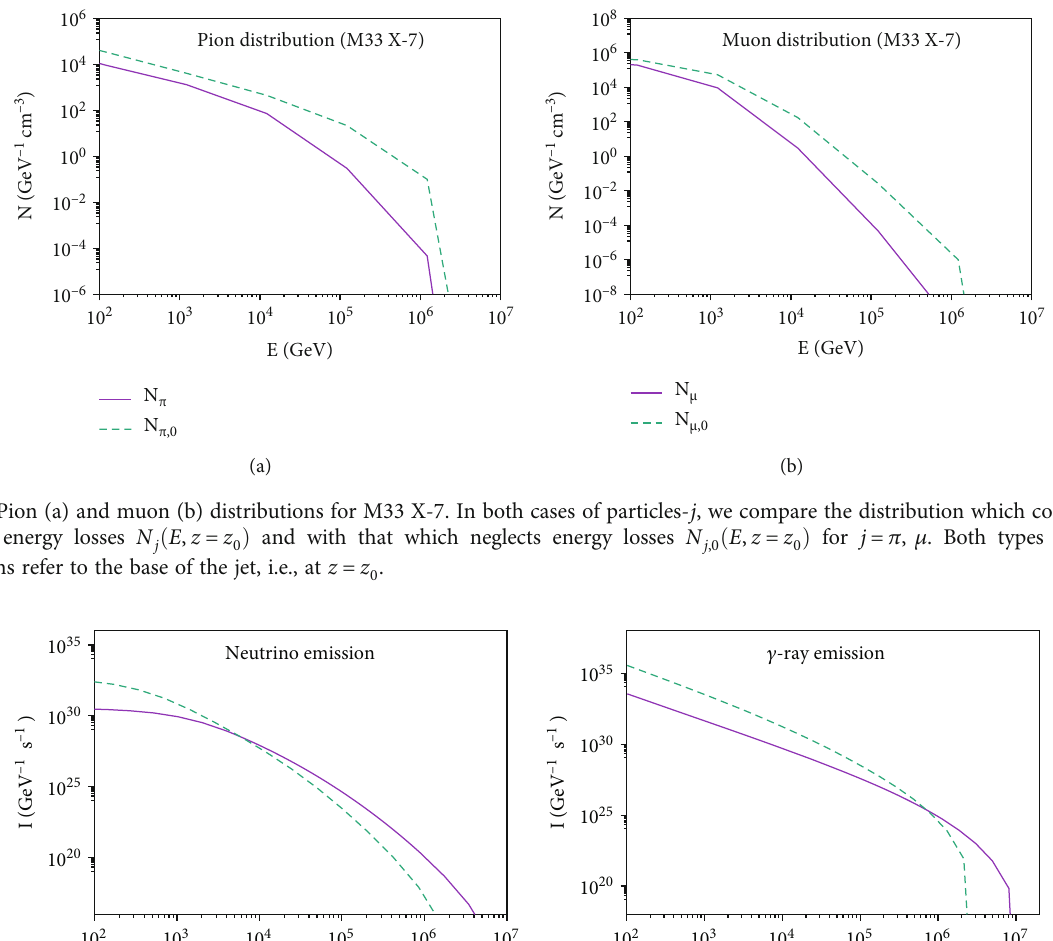
Figure 6: Neutrino (a) and gamma-ray (b) intensities for M33 X-7 and SS